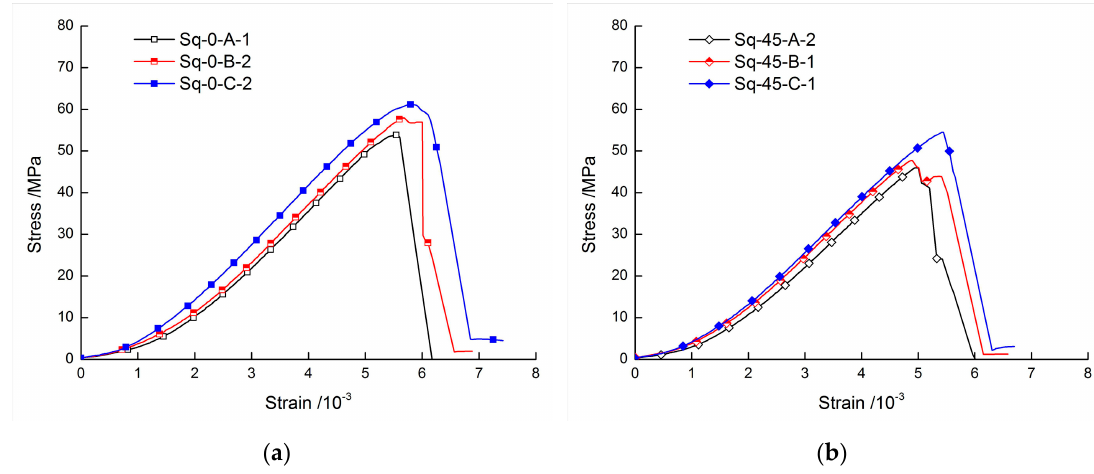
Figure 5. Typical stress–strain curves of specimens containing a square hole under different filling modes: ( a ) α = 0°; ( b ) α = 45°.